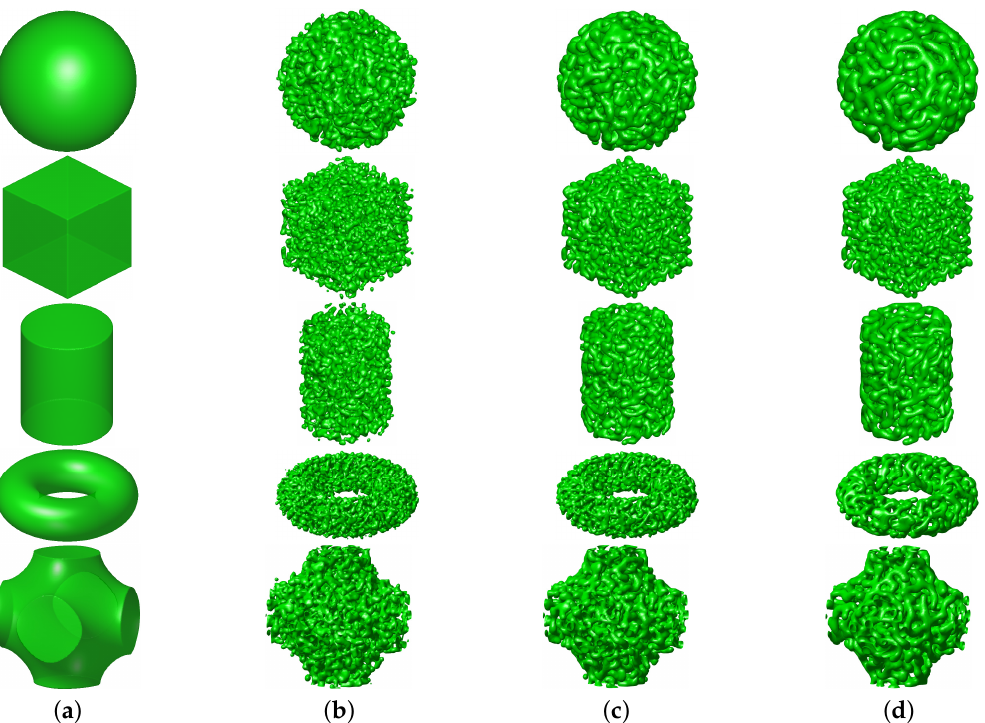
Figure 2. Sphere, cube, cylinder, torus, P surface from top to bottom. ( a ) Surfaces and ( b – d ) zero level isosurfaces of φ at t = 30 ∆ t , 50 ∆ t and 200 ∆ t , respectively, with an initial condition φ ( x , y , z ,0 ) = − 0.3 + rand ( x , y , z ) .